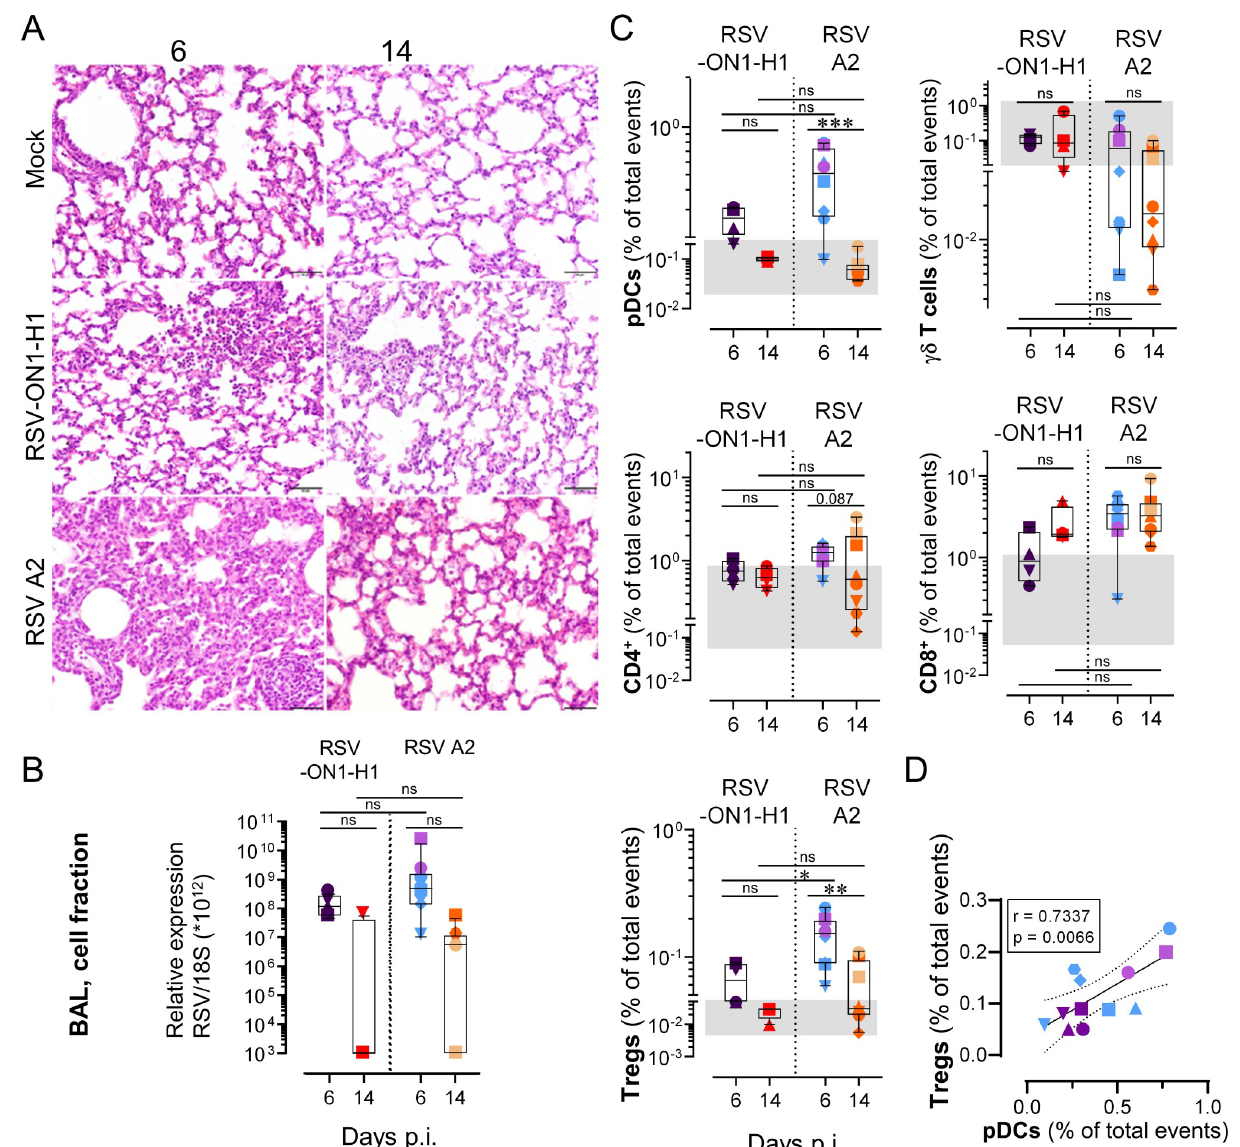
Fig 8. The severity of disease relates to the magnitude of the unconventional bronchoalveolar T cell responses. (A) Representative histological lung tissue sections from mock neonates and neonates infected with RSV-ON1-H1 or RSV A2 strain (40X, HE). At day 6 p.i. the RSV-ON1-H1 infected animals show mild interstitial pneumonia (upper right corner) with accumulation of inflammatory cells within alveoli. No lesions at day 14 p.i. or mock- infected animals. (B) RSV was quantified in the respiratory tract (BAL, cell fraction) of neonates infected with either RSV-ON1-H1 or RSV A2 strain by qPCR. (C) Comparison of immune cell subset trafficking into bronchoalveolar space after infection with RSV-ON1-H1 or RSV A2 strains. (D) Correlation coefficient (r) obtained in BALs with Treg counts calculated as a function of pDC counts. (B-D) Each symbol represents an individual animal (neonates infected with RSV-ON1-H1, n = 4 per time point; neonates infected with RSV A2, n = 8 per time point). The grey zone corresponds to the interval integrating the values of all corresponding mock controls. Boxplots indicate median value (center line) and interquartile ranges (box edges), with whiskers extending to the lowest and the highest values. Groups were compared using one-way ANOVA followed by Turkey’s post hoc test (B, C). Stars indicate significance levels. � , p < 0.05; �� , p < 0.01; ��� , p <